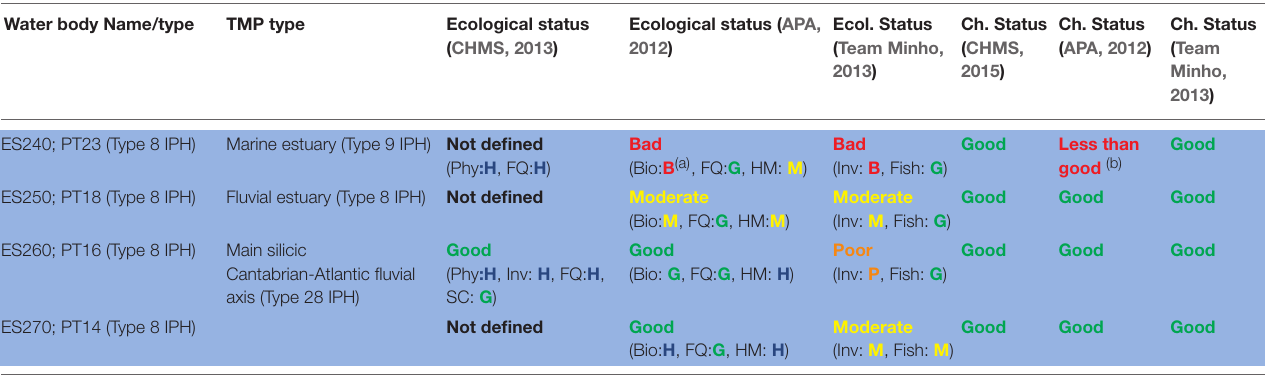
TABLE 1 | Classification of ecological and chemical status of the water bodies from the international Minho estuary conducted by the Spanish administration (CHMS), the Portuguese administration (APA), and the international Team Minho Project (TMP). Water body